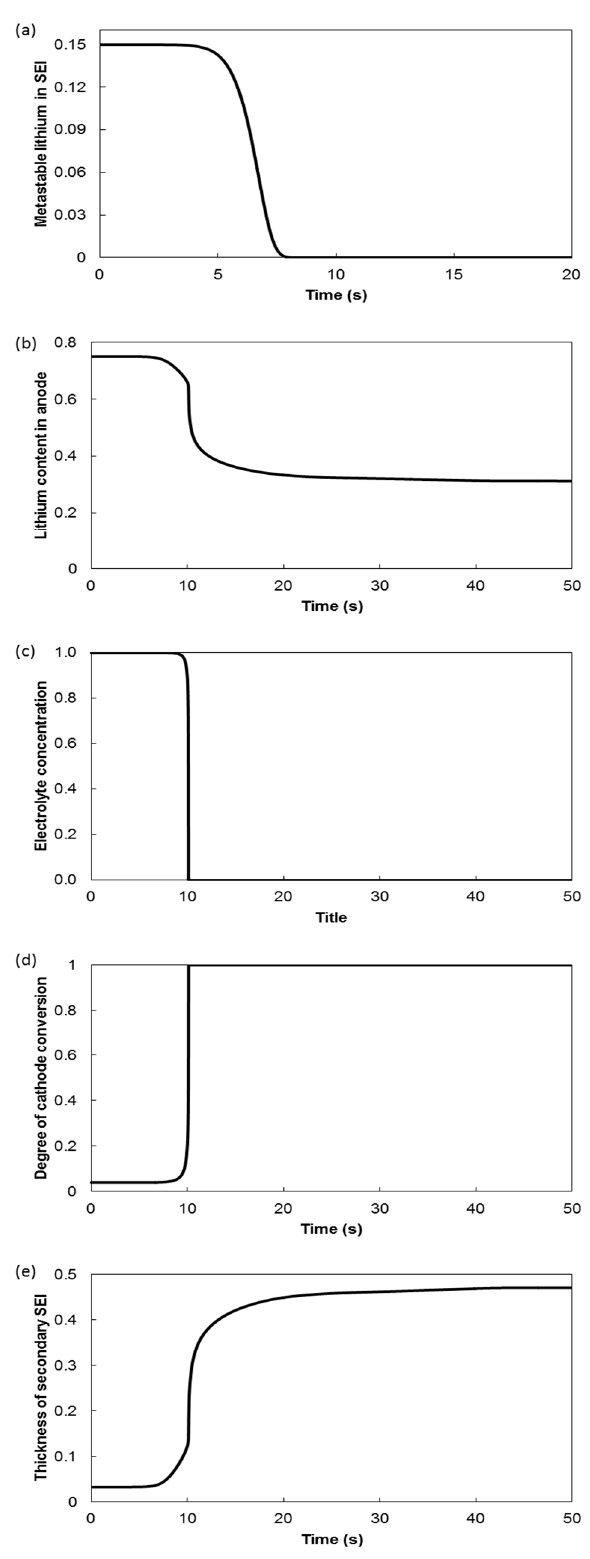
Figure 9. The progress of reaction ( a ) SEI; ( b ) anode; ( c ) electrolyte; ( d ) cathode; and ( e ) secondary SEI thickness, in Cell 5.